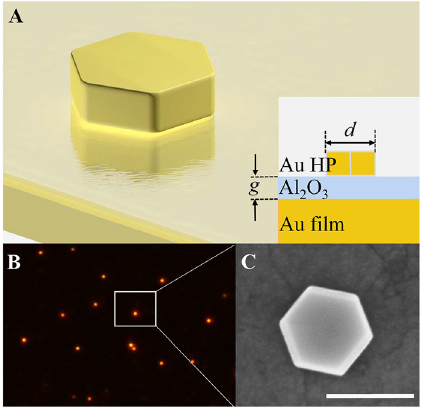
Figure 1: (A) Schematic of hexagonal Au nanoplate-on-mirror (NPoM) consisting a hexagonal Au nanoplate, an ultrasmooth Au film and an Al 2 O 3 spacer. Inset shows the cross-section diagram of hexagonalAuNPoM.(B)Dark- fi eldimageofthehexagonalAuNPoM. The white box indicates a typical hexagonal Au nanoplate measured in our experiment. (C) SEM image of the hexagonal Au NPoM. The scale bar is 200 nm.